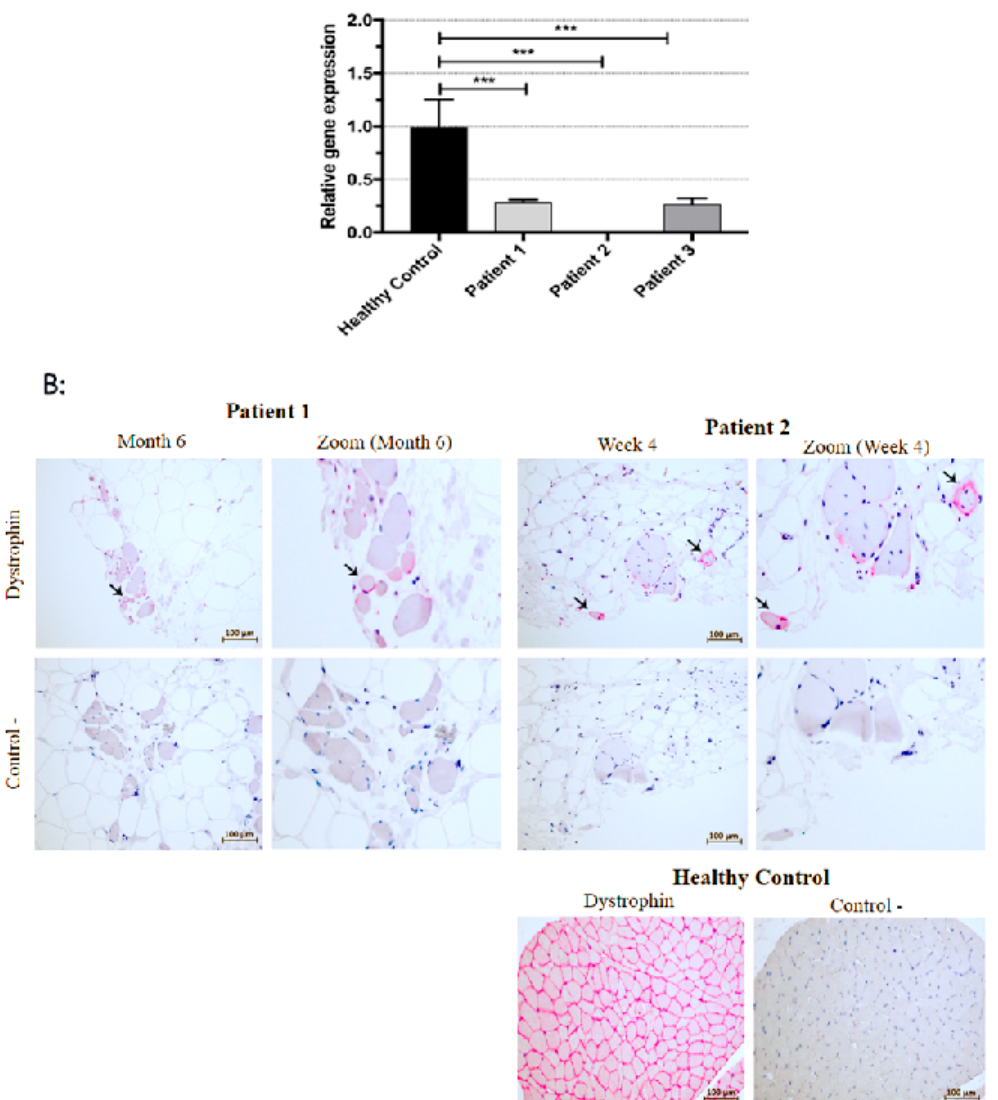
Figure 8. Dystrophin expression at mRNA and protein level. ( A ) Four weeks after the cellular therapy, mRNA for dystrophin gene expression in Patient 1 and Patient 3 was assessed at 20% (RQ = 0.206) and at 27% (RQ = 0.265), respectively, of healthy controls (*** p < 0.001). ( B ) In Patient 1, six months after the co-transplantation of BM-MSCs and myogenic stem / progenitor cells, about 15% of small myofibres expressed dystrophin (arrow). Myofibres expressing dystrophin (arrow) were present in the tissue samples taken from Patent 2 at 4 weeks after cellular therapy (EnVision TM FLEX / HRP detection system staining with HRP magenta substrate chromogen).